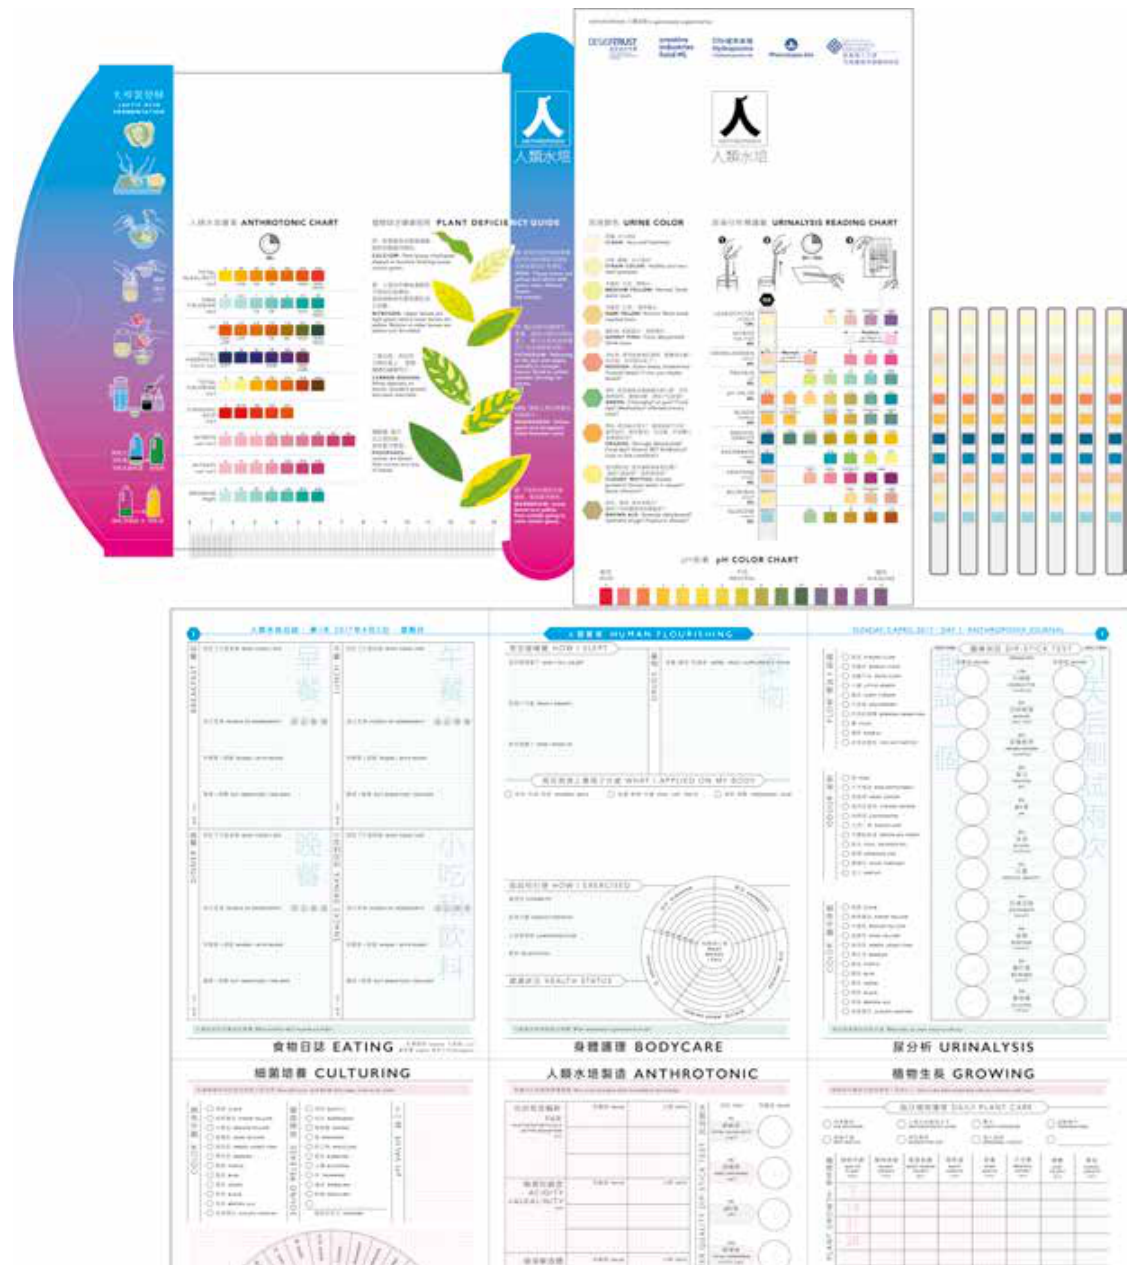
Figure 6: Journal of Mutual Flourishing as a practice of harm-aware- ness. Illustrations by the